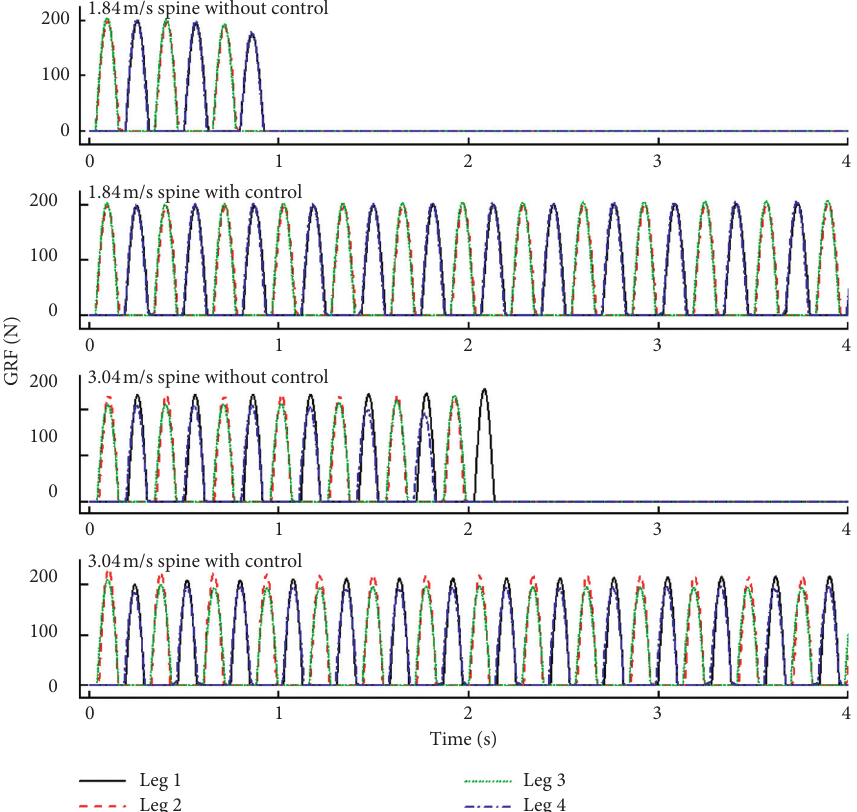
Figure 10: Ground reaction forces of the models when they move at low speed (1.84m/s) and high speed (3.04